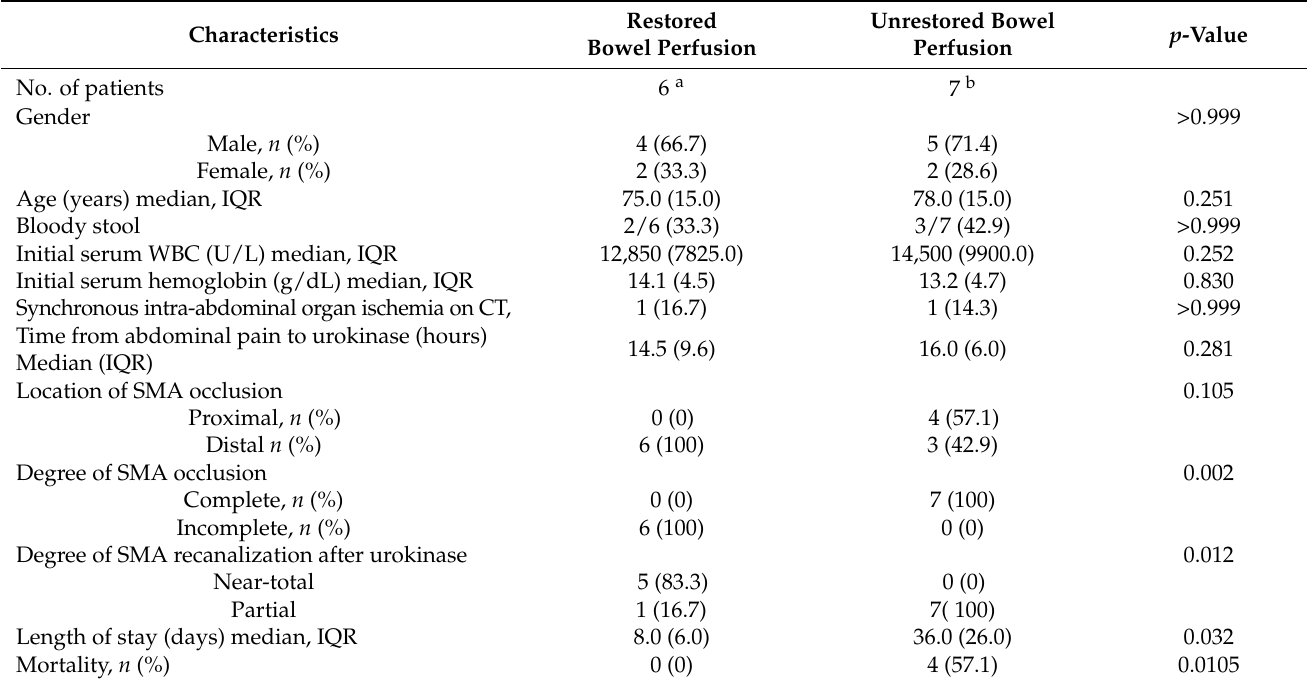
Table 3. Comparison of demographic data and clinical characteristics between the 6 patients with restored bowel perfusion and the 7 patients with unrestored bowel perfusion after urokinase